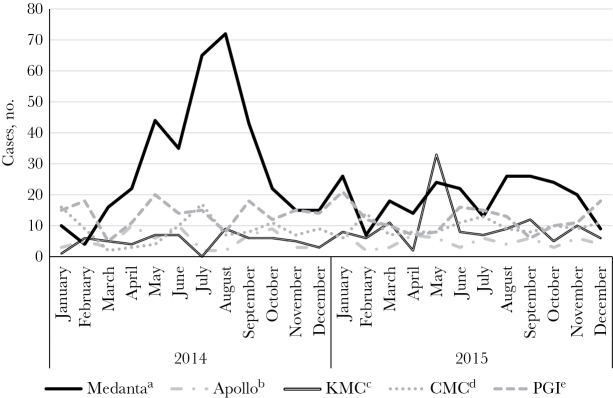
Cases of laboratory-confirmed enteric fever, by month and hospital site, India, 2014–2015 (n = 1418). aMedanta Hospital, Gurugram, Haryana; bApollo Hospital, Kolkata, West Bengal; cKasturba Medical College–Manipal University Hospital, Manipal, Karnataka; dChristian Medical College, Vellore, Tamil Nadu; ePostgraduate Institute of Medical Sciences, Chandigarh.